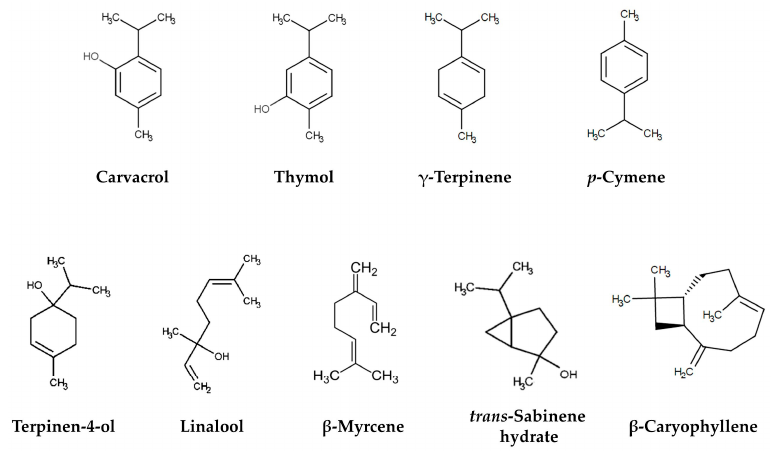
Figure 1. Some of the major constituents of the essential oils of oregano.